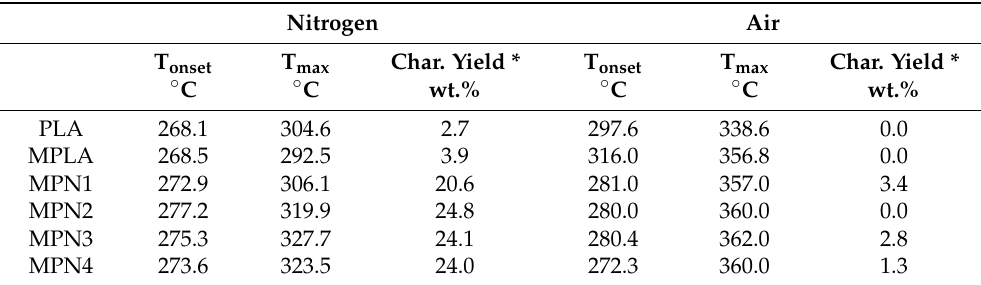
Table 3. TGA data of MPLA biocomposites under nitrogen and air